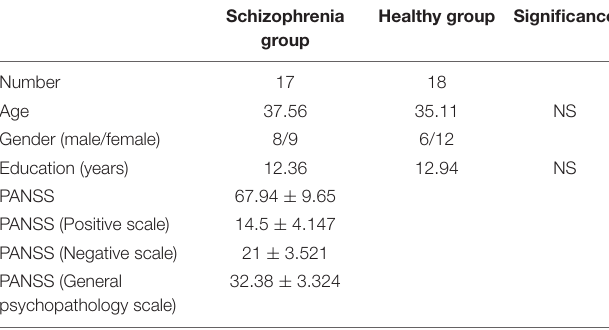
TABLE 1 | Basic features of the two participant